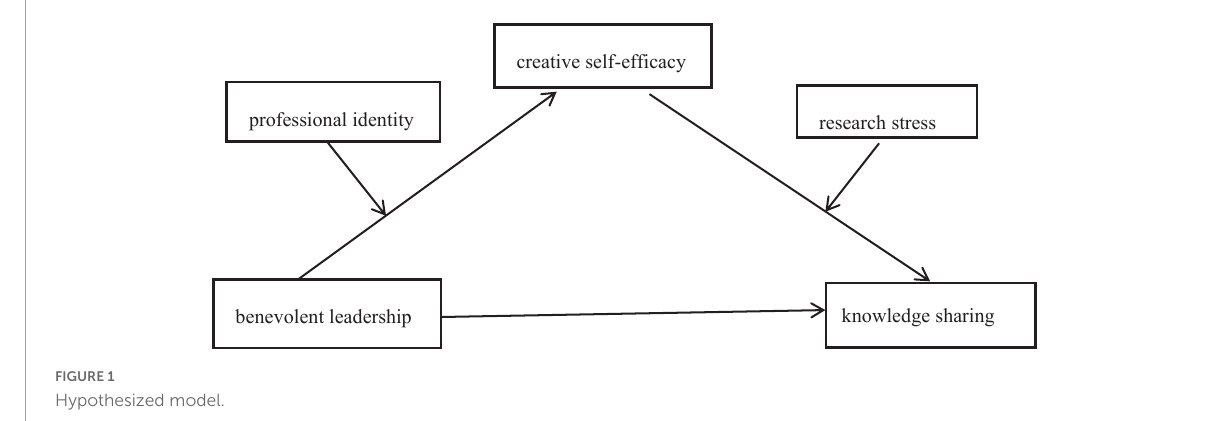
FIGURE1 Hypothesized